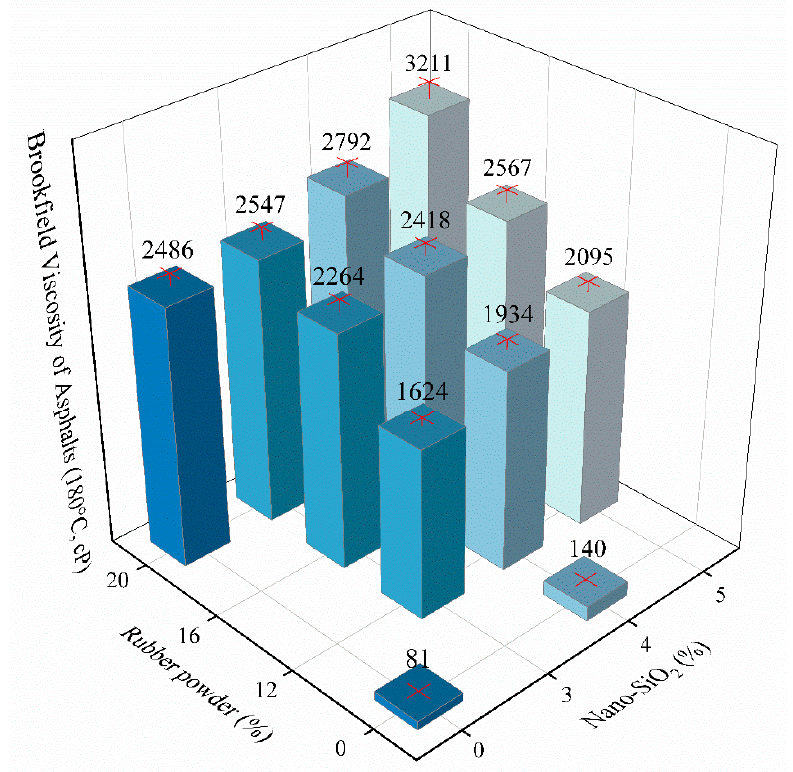
Figure 3. Brookfield viscosity of di ff erent experimental groups (180 ◦ C,